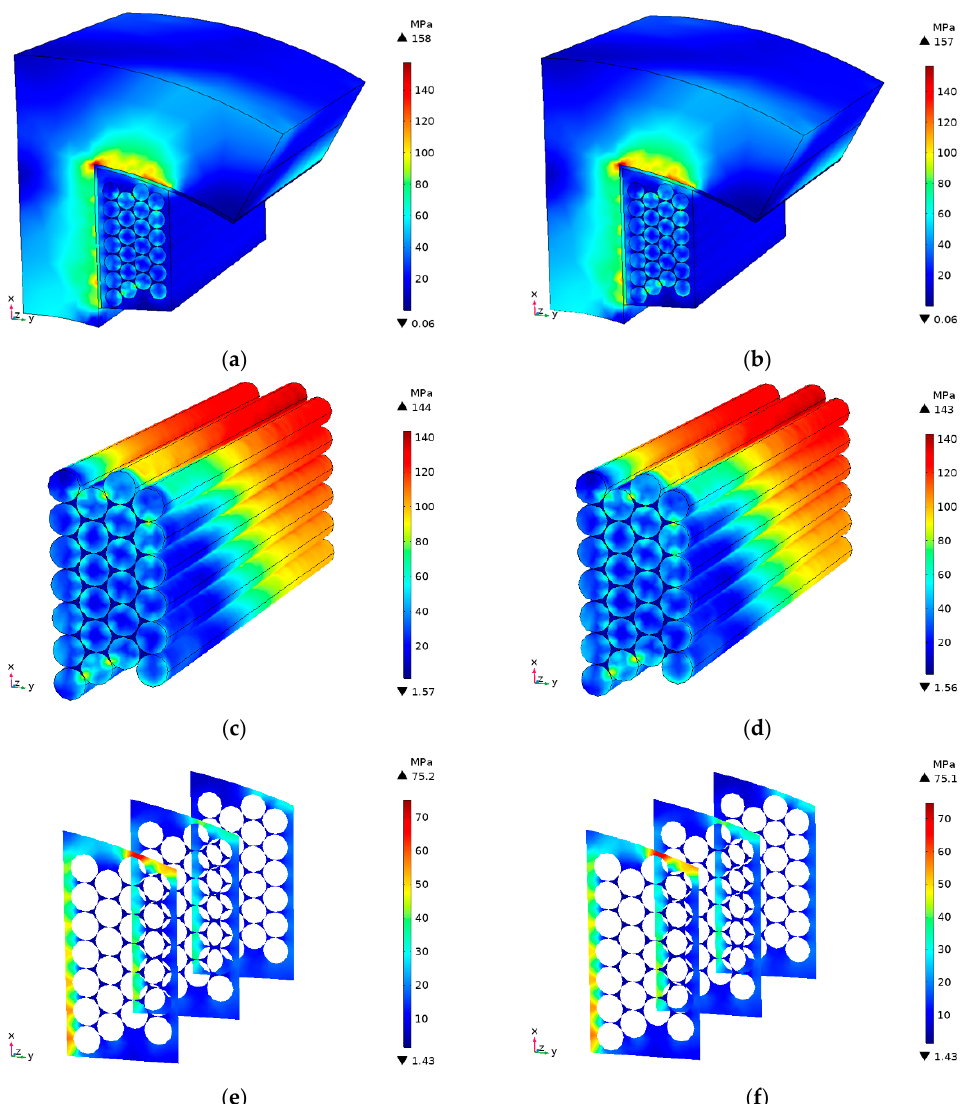
Figure 9. Resulting stress distribution for WJ1 ( a , c , e ) and WJ2 ( b , d , f ). ( a , b ) show the overall stress distribution; ( c , d ) show the stress in the copper coils; ( e , f ) show the stress in three different positions along the axial length of the machine.